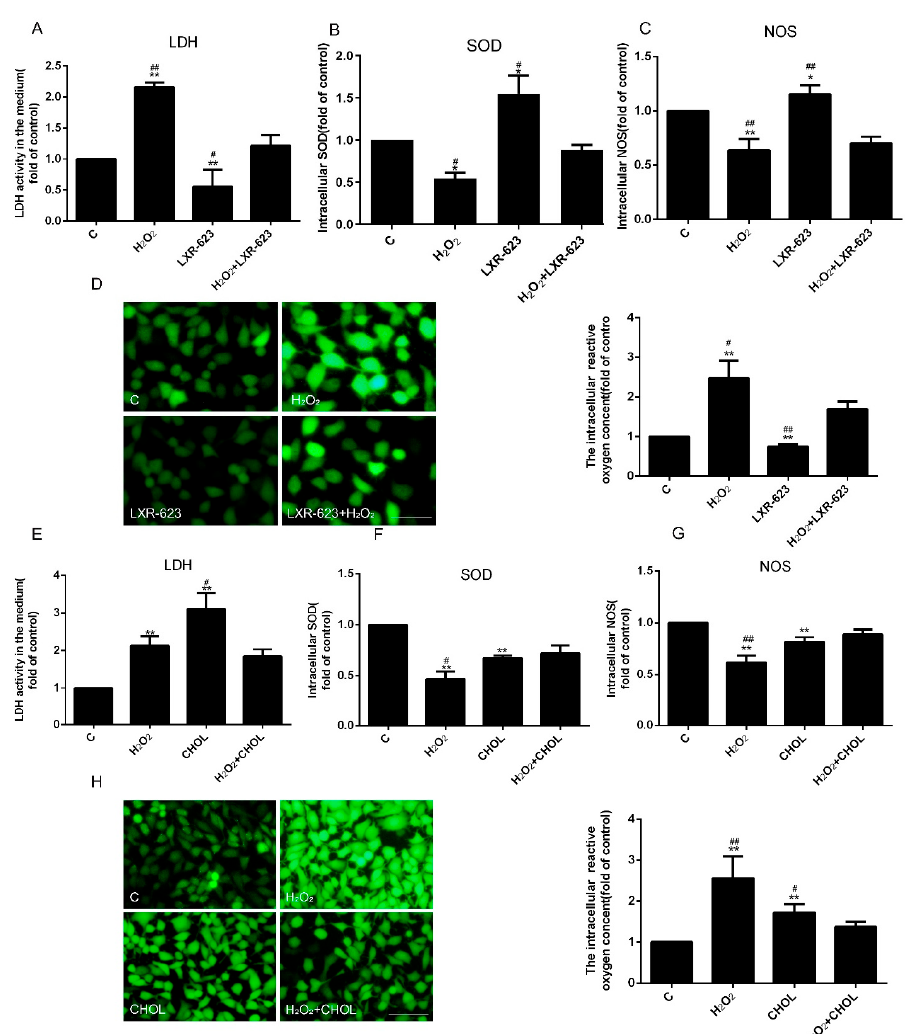
Figure 3. LXR-623 can attenuate H 2 O 2 -induced endothelial cell injury by increasing cholesterol efflux, and adding cholesterol extracellularly can induce cell damage by promoting the deposition of intracellular cholesterol. ( A ) LDH, ( B ) SOD, and ( C ) NOS levels were measured with assay kits. ( D ) The activity of ROS was detected by fluorescemce probe DCFH-DA (15 µ mol/L). ( E ) LDH, ( F ) SOD, ( G ) NOS levels were detected with assay kits. ( H ) Using fl uorescemce probe DCFH-DA (15 µmol/L) to detect ROS activity (magni fi cation 10×). n = 3, * p < 0.05, and ** p < 0.001 vs. the C group; # p < 0.05 and ## p < 0.001 vs. the H 2 O 2 + LXR-623 group; # p < 0.05 and ## p < 0.001 vs. the H 2 O 2 + CHOL group. The C (control) group of LXR-623 and cholesterol were treated by DMSO and chloroform, respec- tively; H 2 O 2 , cells treated with H 2 O 2 (500 µmol/L) for 24 h; LXR-623, cells treated with LXR-623 (5 µmol/L) for 24 h; H 2 O 2 + LXR-623, cells treated with LXR-623 (5 µmol/L) for 2 h and then treated with H 2 O 2 (500 µmol/L) for 22 h; CHOL, cells were treated by cholesterol (100 µmol/L) for 24 h; H 2 O 2 + CHOL, cells were fi rstly treated by cholesterol (100 µmol/L) for 2 h, and then H 2 O 2 (500 µmol/L) was used to treat cells for 22 h. The scale of the images is 100 µm.